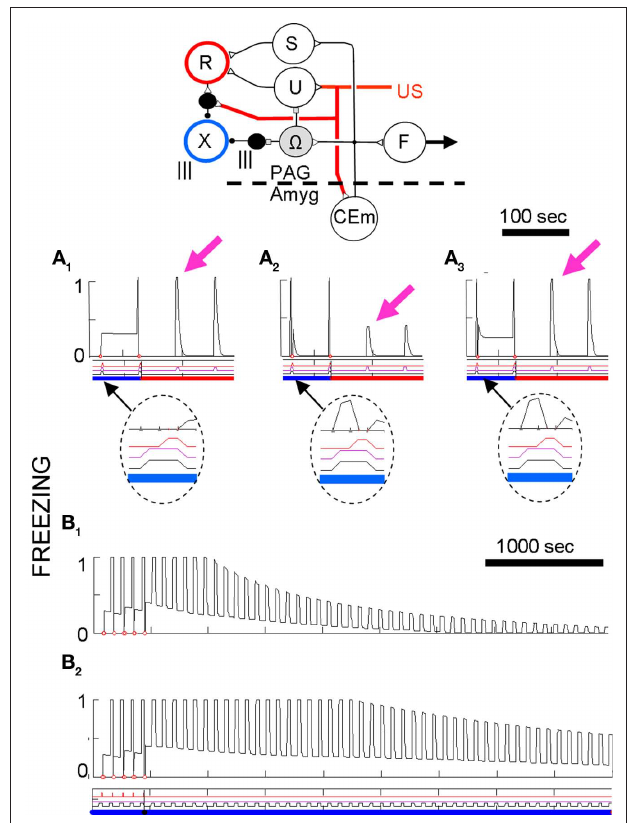
FigurE 11 | Effects of pAg opiate antagonist on blocking and extinction. The circuit that controls the activity of globally distributing reinforcement r and extinction x neurons (from Figure 5 ) is shown above. (A) Blocking. Each graph shows two reinforced co-occurrences of CS1 and CS2 in context A followed by test presentations of CS2 in context B. Details of first reinforced co-presentation of CSs are shown in the blow-ups. (A ) Control; no prior 1 experience. (A ) CS1 was previously conditioned in context C. Note that the 2 response to CS2 is less than in A because the well-conditioned CS1 partially 1 blocked learning. (A ) Same as A except that opiate receptors were 70% 3 1 blocked during training (simulated by attenuating input from Ω -cells input to their targets) during the two conditioning trials. Magenta arrows mark initial test responses. (B) Effect of PAG opiate receptor block on extinction. (B ) 1 Normal conditioning and extinction. (B ) Same as B except opiate receptors 2 1 partially blocked during